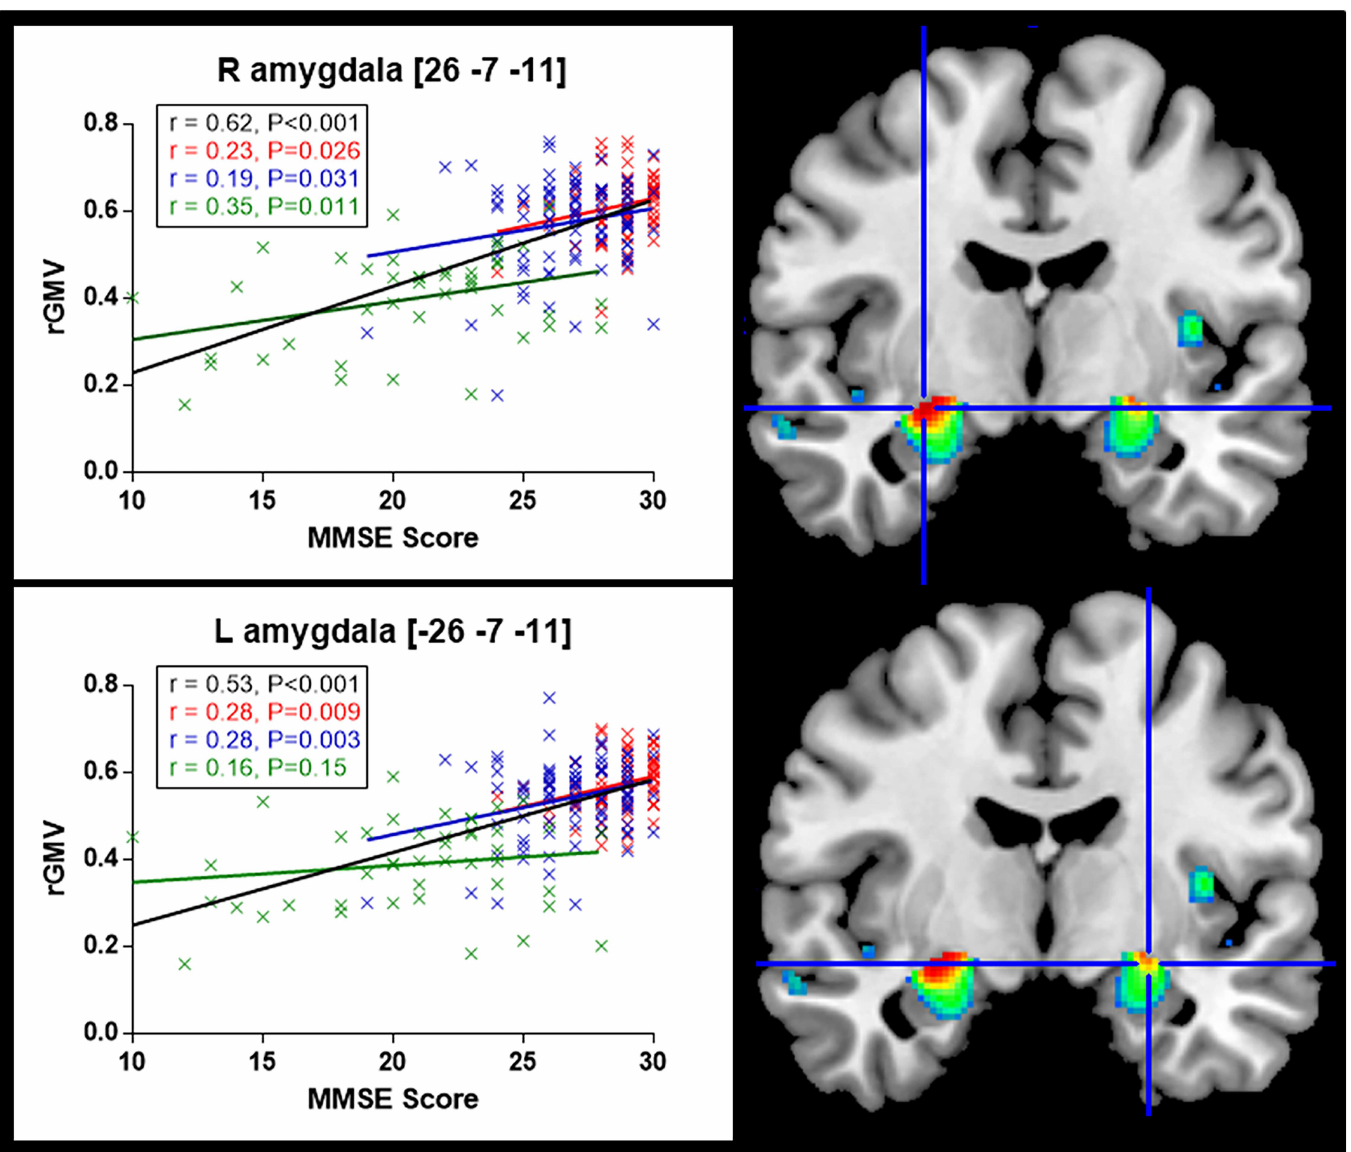
Fig 3. Correlation between the MMSE score and the regional gray matter volume (rGMV) in right (R) and left (L) amygdala according to participants’ diagnostic category. Plots points indicate the quantification of the VBM signal sampled from the voxels of the right and left amygdala. In black: whole sample of participants; red: cognitively healthy participants; blue: participants with MCI; green: participants with AD. L, left in [x y z], MNI coordinates. Results are shown for P < 0.05 corrected for multiple comparisons FWE corrected.